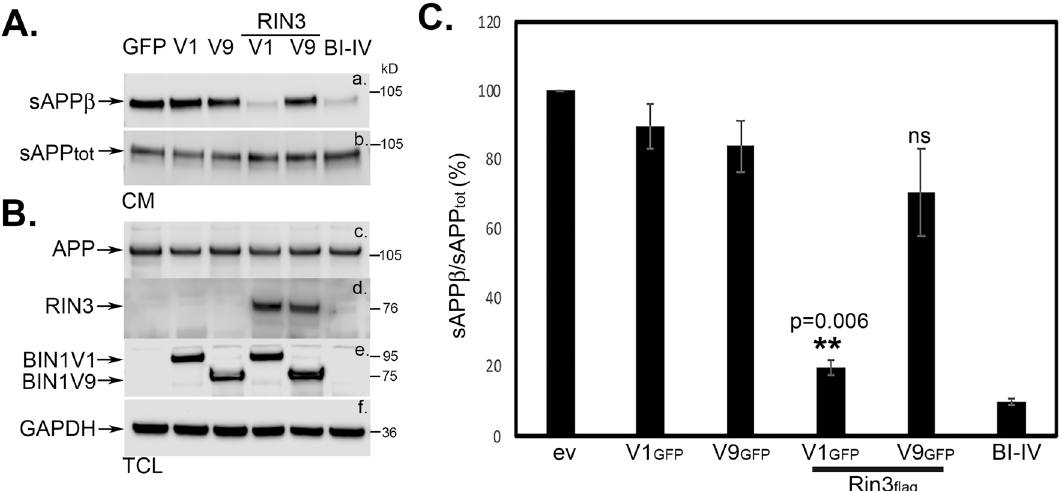
Figure 2. The neuronal isoform BIN1V1, but not the non-neuronal BIN1V9, reduces β-secretase-mediated processing of APP in a RIN3-dependent manner. (A) Representative immunoblot image of the conditioned media (CM) or total cell extracts (TCL) of FACS enriched N2A APP cells overexpressing GFP (GFP), BIN1V1 GFP (V1), BIN1V9 GFP (V9), BIN1V1 GFP + RIN3 flag (V1 + RIN3) or BIN1V9 GFP + RIN3 flag (V9 + RIN3). sCM were probed with anti-sAPPβ (a.) or 22C11 (b.) to detect sAPPβ or sAPP tot , respectively. CM from cells pre-treated with 5 μM BACE1 inhibitor IV (BI-IV) for 16 h was also probed to confirm detection of sAPPβ. Total cell lysates (TCL) were probed with anti-APP 22C11 (c.), anti-RIN3 (d.), anti-BIN1 (e), and anti-GAPDH (f.) to detect APP, RIN3 flag , BIN1V1 GFP /BIN1V9 GFP , and GAPDH, respectively. ( B) Quantitation of sAPPβ release (anti- sAPPβ) compared to sAPP tot (22C11) from the cells expressing indicated proteins. Error bars represented ± SEM from three independent experiments. ** p <